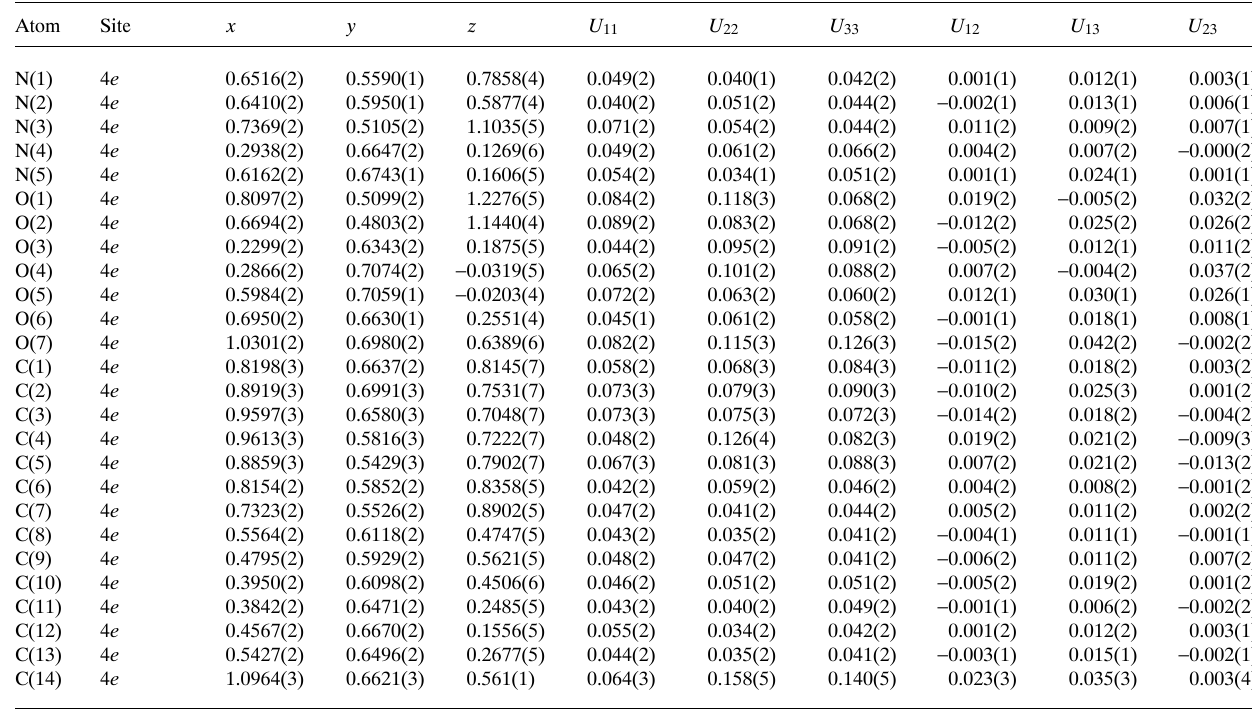
Table 3. A tomic coordin a tes a nd displ a cement p a r a meters (in Å 2 ) .